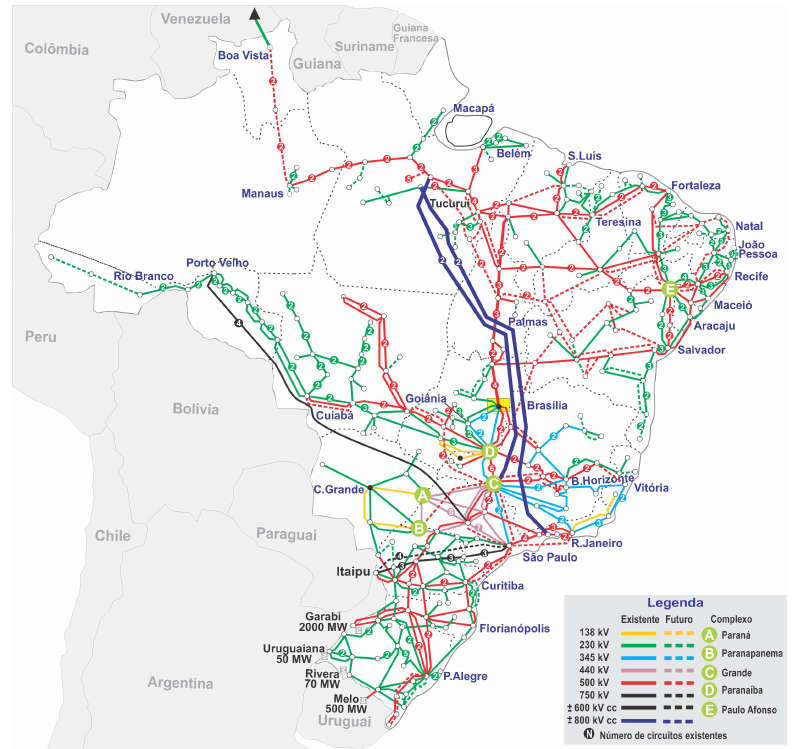
Figure 1. Map of the National Interconnected System with main transmission trunks [43].